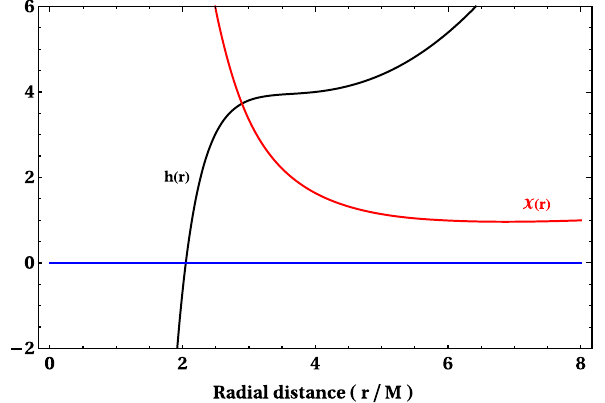
Fig. 3 It is shown that the singularity is always naked and there is neither event nor cosmological horizon. Here we set (cid:2) M 4 = 0 . 06 and l = 4 M . Given that the singularity is naked, the spacetime is not physically